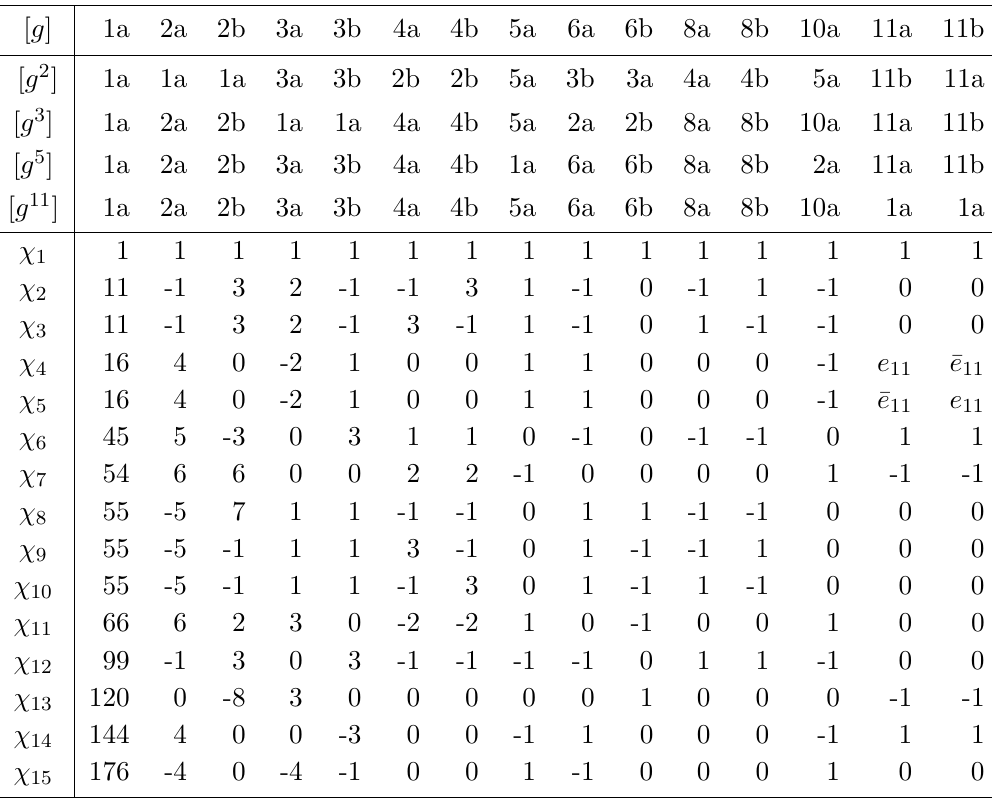
p (cid:0) (cid:1) (cid:0) 1 + i 11 2